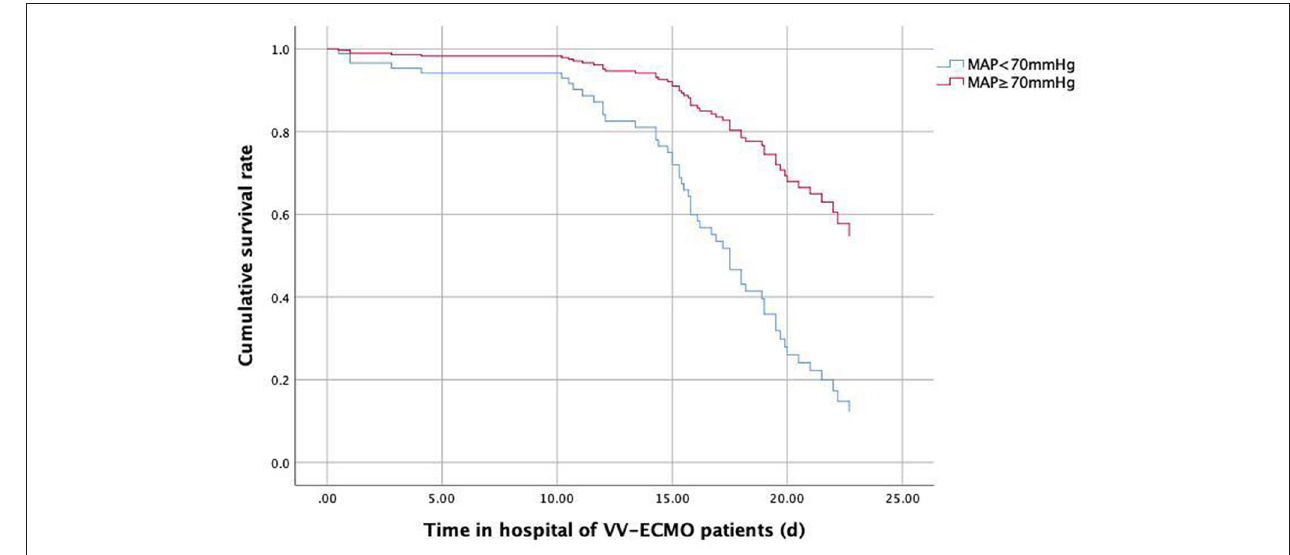
FIGURE 5 | Cox regression survival analysis curve of VV-ECMO patients’